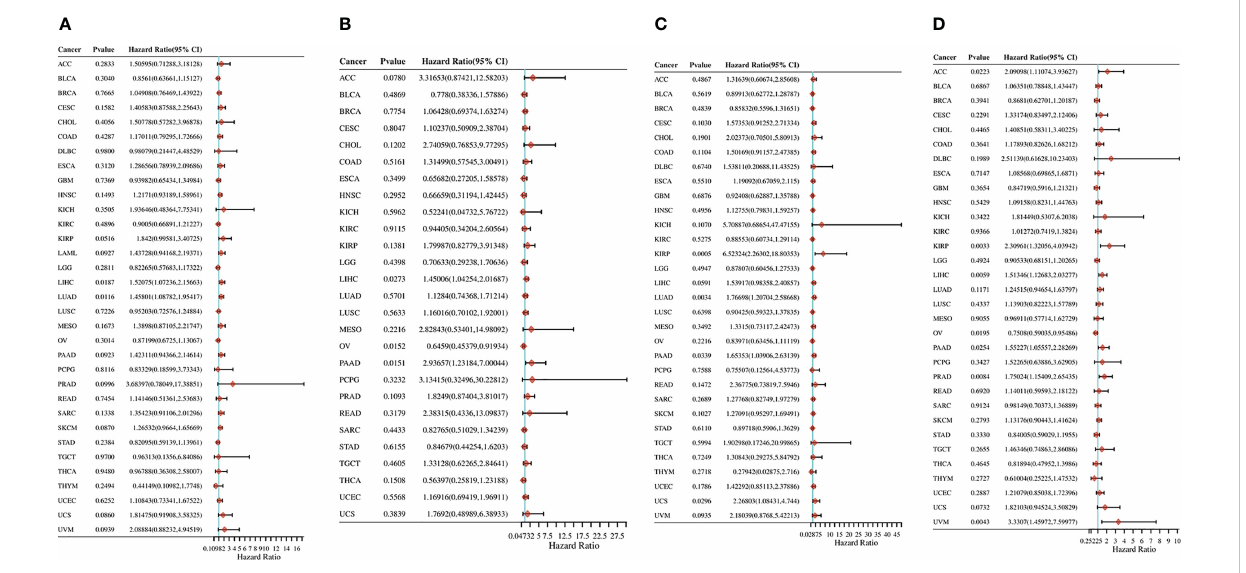
FIGURE 11 Pan-cancer analysis of the correlation between RRS1 expression and prognosis. (A) The correlation between RRS1 expression and OS in diverse cancers. (B) The correlation between RRS1 expression and DFS in diverse cancers. (C) The correlation between RRS1 expression and DSS in diverse cancers. (D) The correlation between RRS1 expression and PFS in diverse